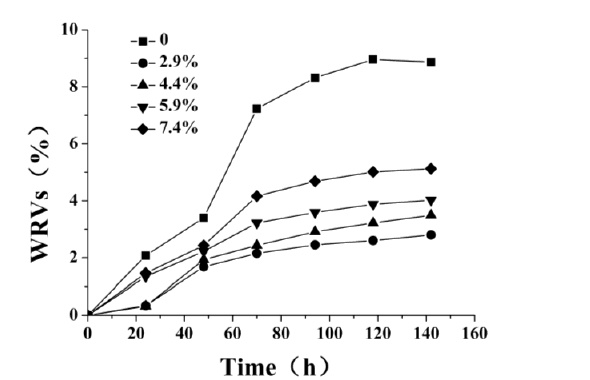
Figure 3. WRVs of N -phthaloyl acylated chitosan membranes with different crosslinking